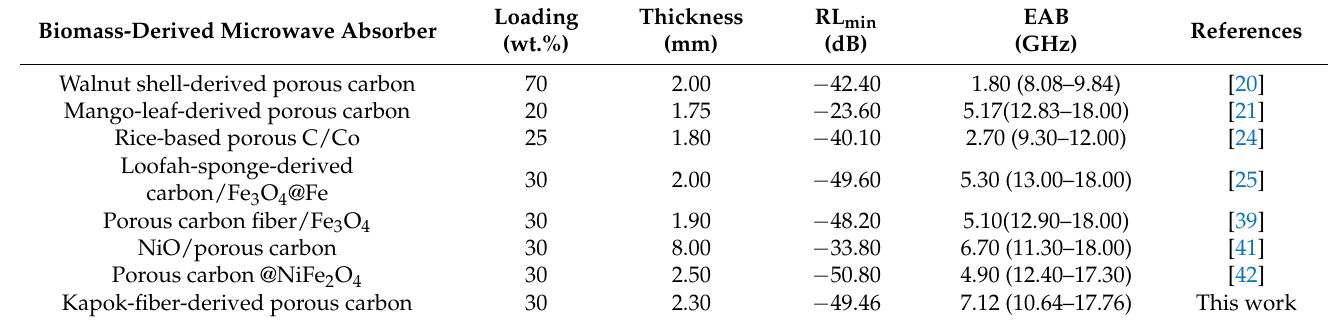
Table 1. Typical microwave-absorbing materials based on biomass-derived carbon and their